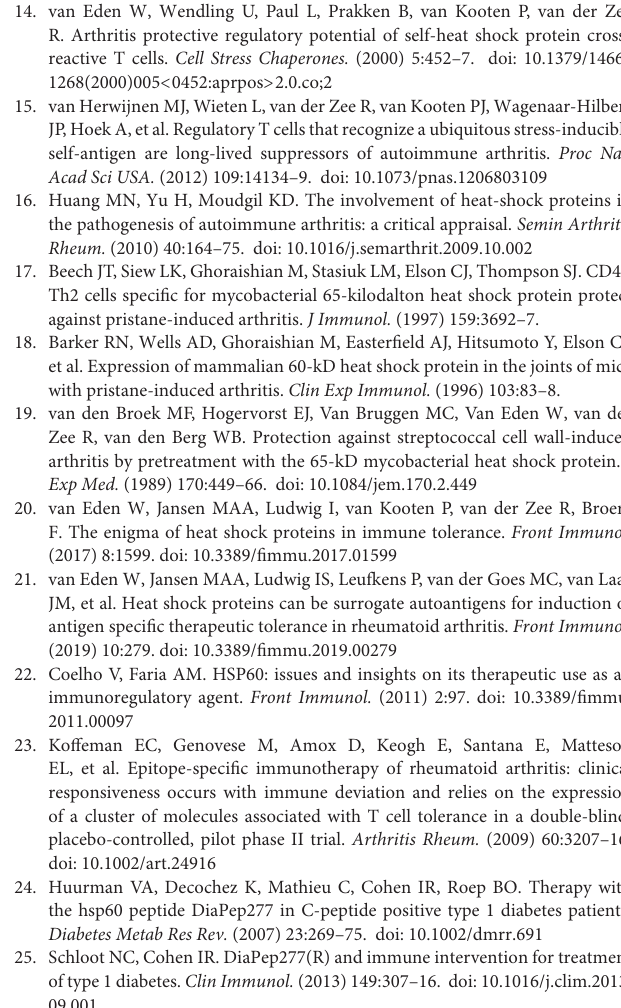
FIGURE S1 | Strategy for flow cytometry analysis of cytokine-producing cells from BALB/c mice with collagen-induced arthritis (CIA). Cells were harvested from spleens of BALB/c mice treated with XM17 broth (C), L.lactis -EP (EP) or HSP-Lac (HSP) for four days and immunized 10 days later with CII + OVA + CFA for CIA induction. IFN- γ -producing (G) and TNF- α -producing (H) CD4 + T cells in spleens of mice at days 42 and 95 of disease development were evaluated by intra-cellular staining of the cytokines and analysis by flow cytometry. Gate strategy used to analyze cytokine-producing CD4 + T cells is shown. FIGURE S2 | Histological, clinical and antibody analysis of in BALB/c mice with collagen-induced arthritis (CIA) treated with HSP65-producing L.lactis. Representative histological sections as it was used for score determination (A) . Upper row shows intense (1) hyperplasia (pannus), (2) bonne erosion and (3) inflammatory infiltrate. Lower row shows a moderate degree of these same pathological events. For histological scoring purposes, intense events scored 2, moderate 1 and absent, 0. (B) Volume of hind paw taken with a plethysmometer.